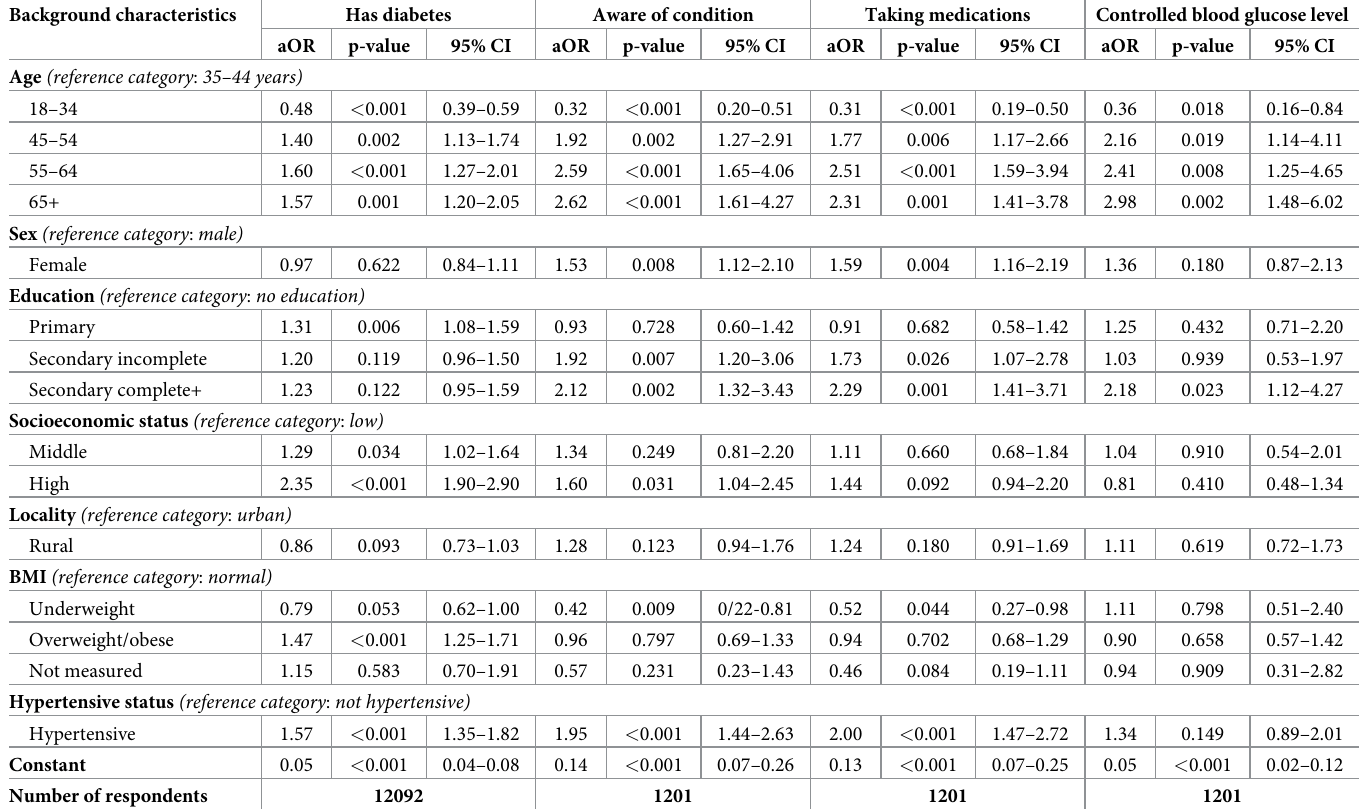
Table 3. Adjusted odds ratios of diabetes prevalence, awareness, and management among the adult population, Bangladesh 2017–18. Background